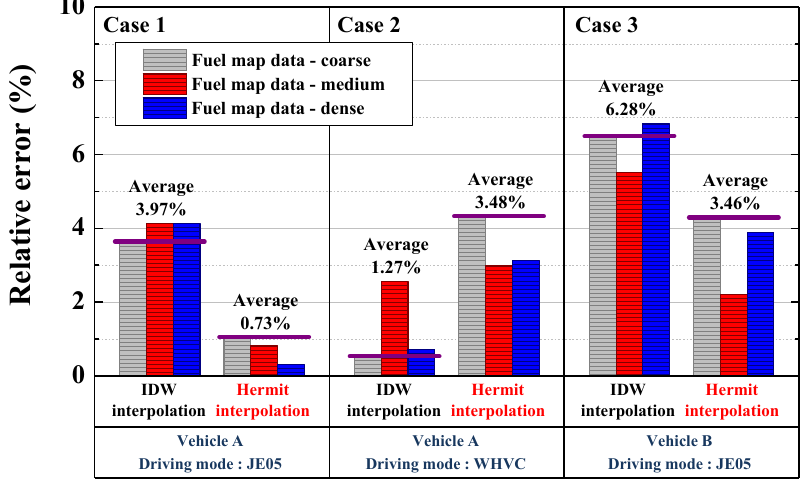
Figure 12. Change of predicted fuel efficiency results with variation of the number of data points and interpolation method.